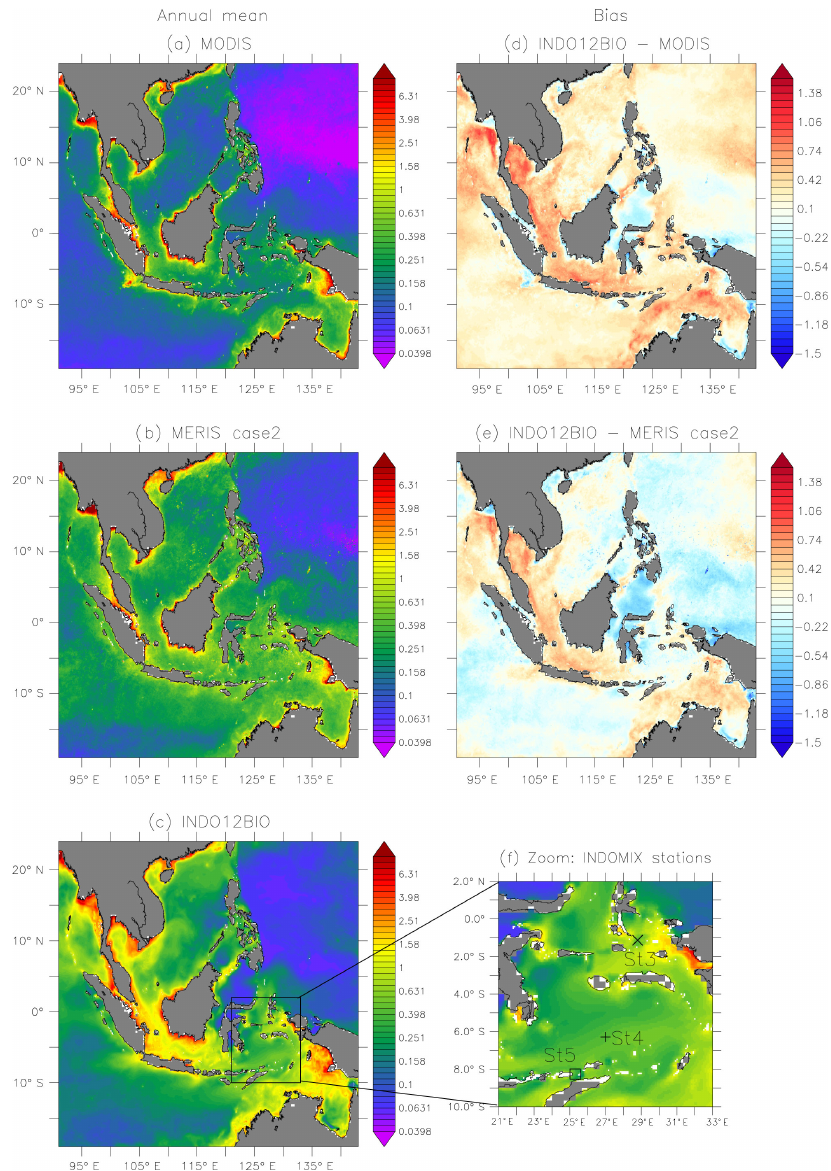
Figure 4. Left: annual mean of surface chlorophyll a concentrations (mgChlm − 3 ) for year 2011: MODIS case-1 product (a) , MERIS case-2 product (b) and INDO12BIO simulation (c) . Right: bias of log-transformed surface chlorophyll (model-observation) for the same year. The model was masked as a function of the observation, MODIS case-1 (d) or MERIS case-2 (e) . Location of three stations sampled during the INDOMIX cruise and used for evaluation of the model in Sect. 4.4 (f)